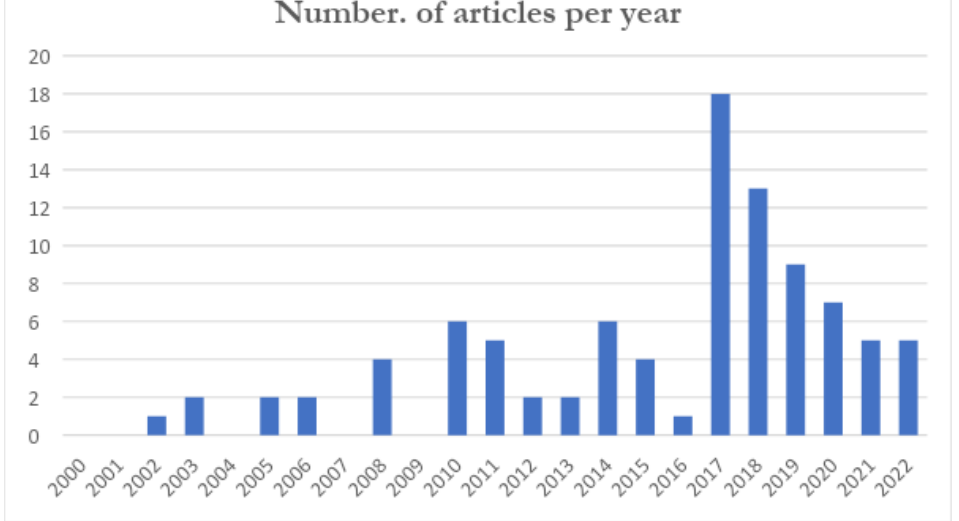
Figure 1. Number of articles on polygamy per year.